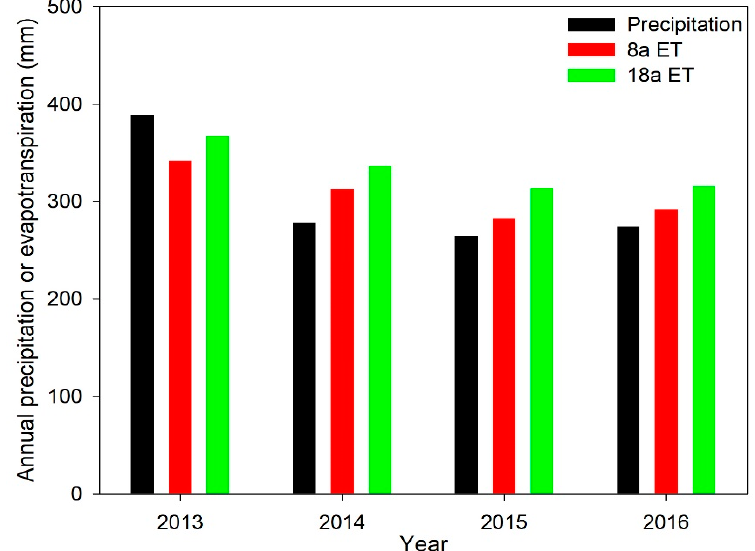
Figure 4. Annual precipitation and evapotranspiration ( ET ) for the 8- and 18-year-old apple orchards (8a and 18a, respectively) in 2013, 2014, 2015, and 2016.